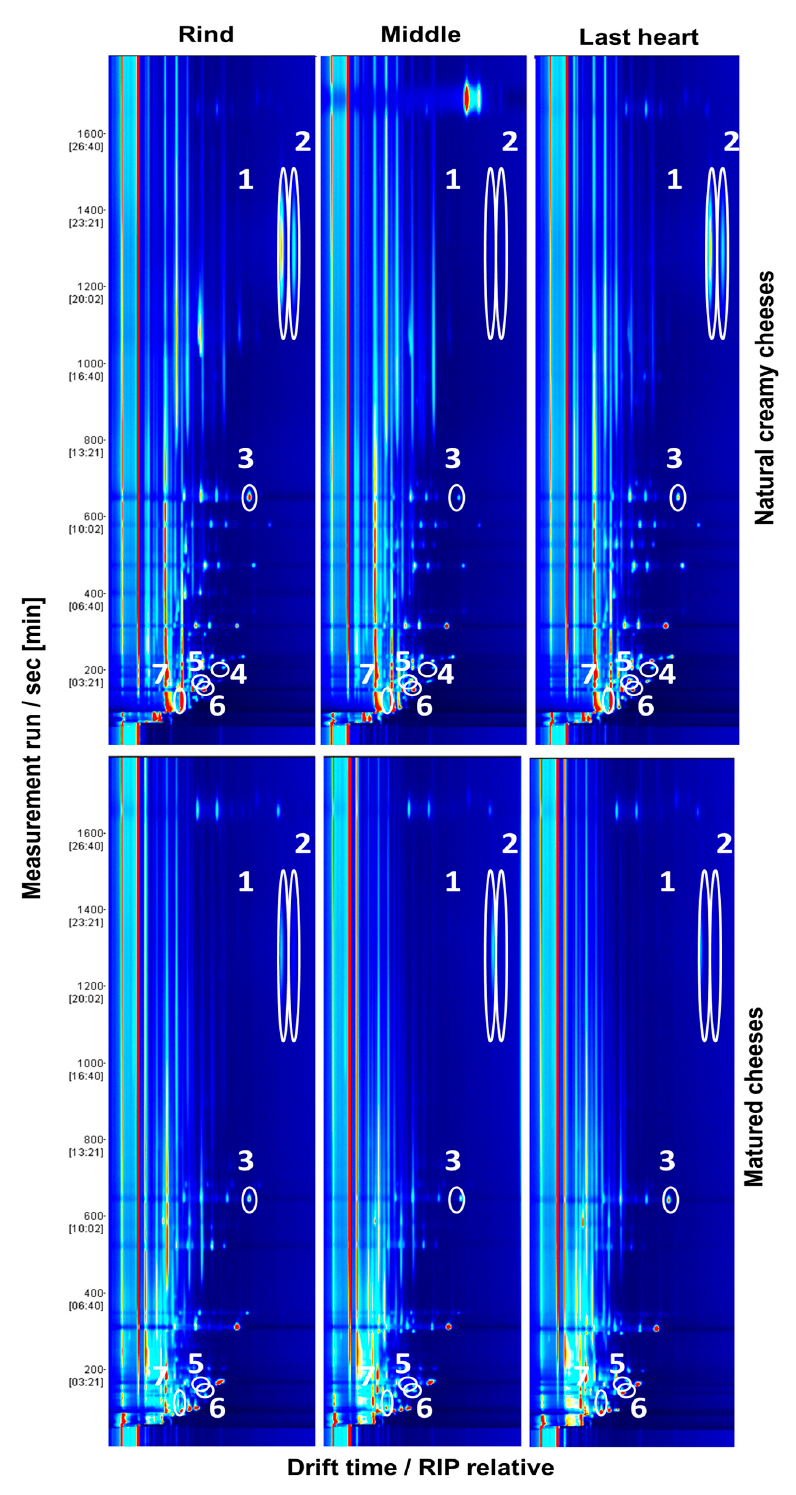
Figure 2. VOCs detected in artisanal raw sheep milk (natural creamy or matured) cheeses by GC–IMS. VOCs highlighted: (1) 2-heptanol; (2) 3-hydroxybutan-2-one; (3) 2-heptanone; (4) 3-methyl-1-butanol; (5) 2-butanol; (6) 2-pentanone; (7) 2-butanone.